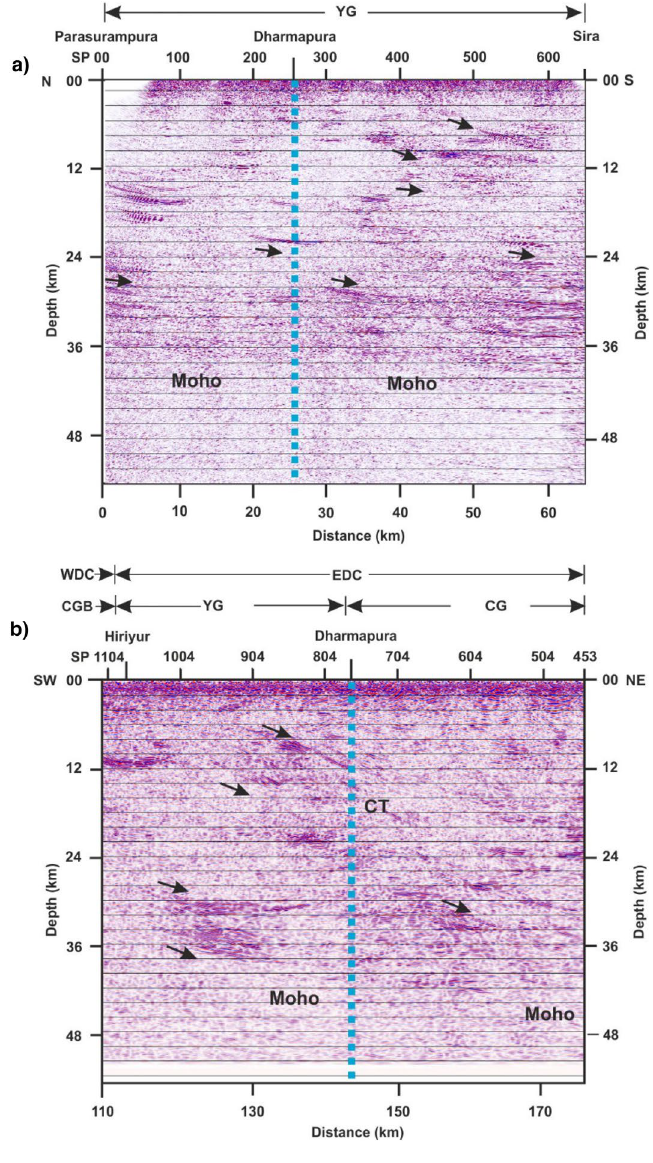
Figure 6. CRS migrated seismic reflection section along ( a ) Parasurampura-Sira cross-profile, along the strike. A subhorizontal reflection band observed from 16–24 km depth corresponds to the Chitradurga thrust of the main profile. ( b ) A part of the main profile (65 km long), across the strike (after Mandal et al. 21 ). The vertical dashed line represents the intersection of the two profiles. YG-Younger Granite; CGB-Chitradurga Greenstone Belt; CG-Closepet Granite; EDC-Eastern Dharwar Craton; WDC-Western Dharwar Craton; CT-Chitradurga Thrust. Arrows indicate dipping reflection fabric representing the structural features of the